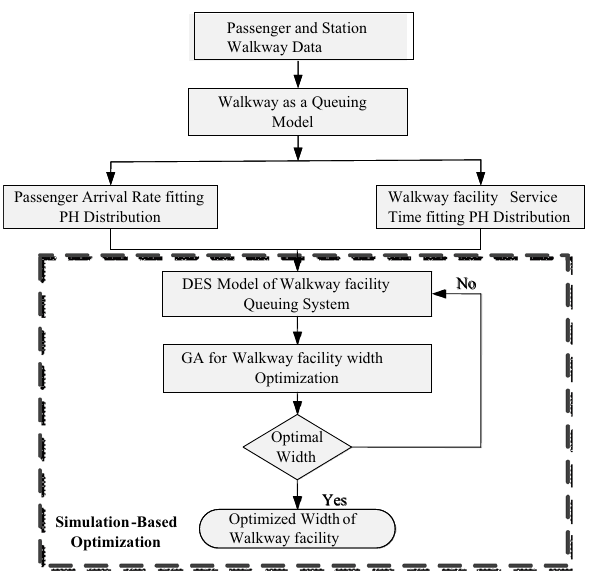
Fig. 3 Simulation - based optimization for the walkway width